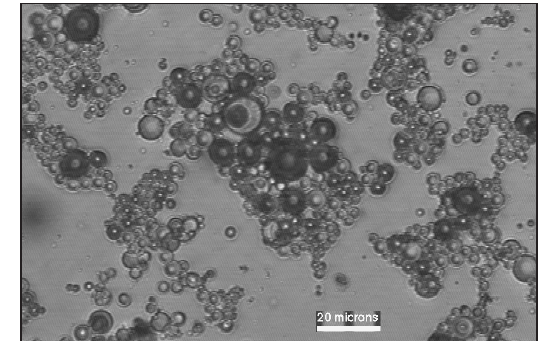
Figure 8 (right): Mixture of hydrophilic glass spheres suspension and PGPR emulsion after 18 min. mixing time.